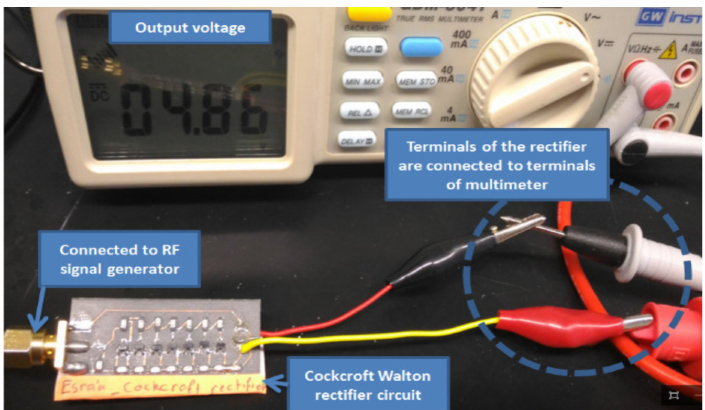
Figure 18. Testing and measurements setup for Cockcroft–Walton multiplier